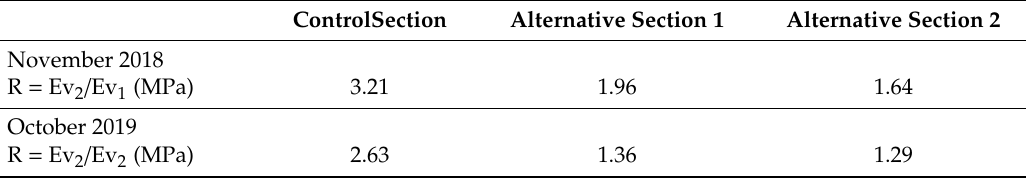
Table 6. Ev 2 / Ev 1 relationship for each